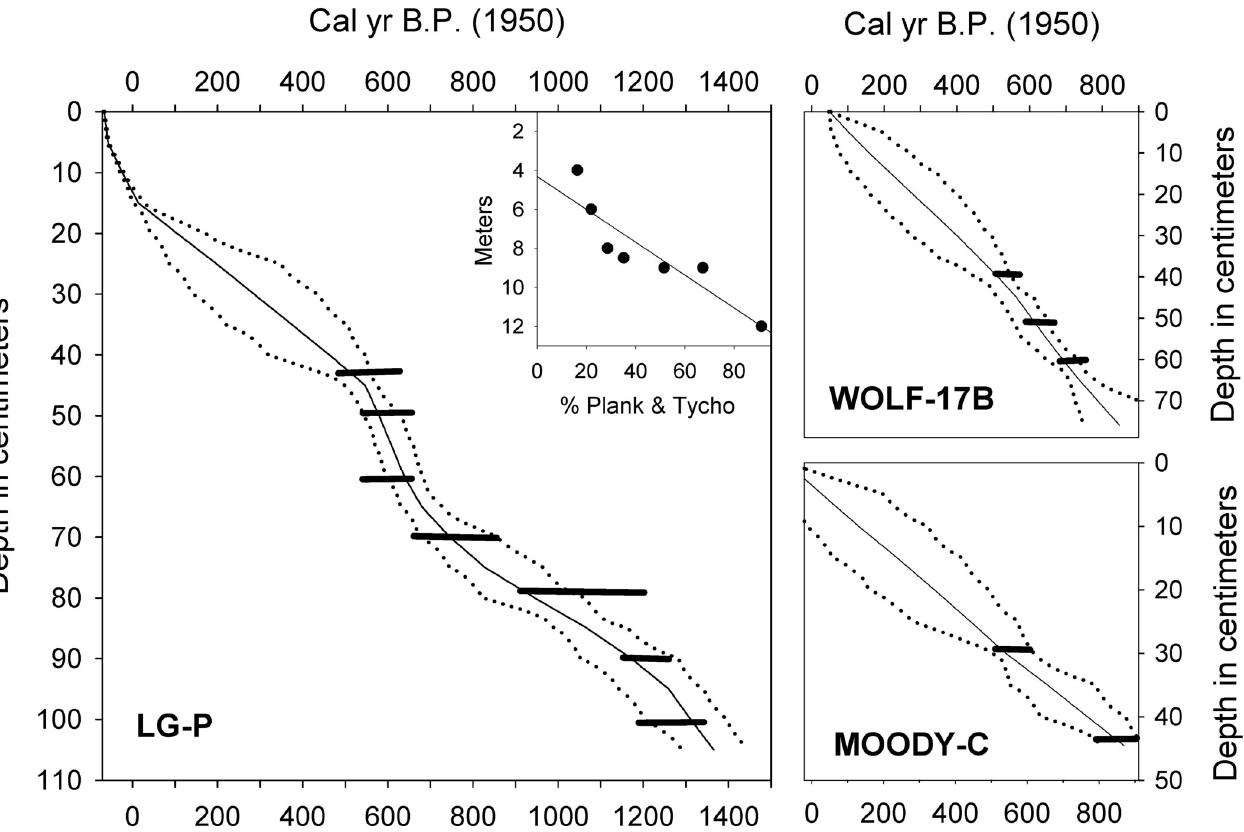
Fig 2. Radiocarbon age-depth models for sediment cores from Little Green Pond (LG-P), Wolf Lake (WOLF-17B), and Moody Pond (MOODY-C). Horizontal bars represent calibrated age probability ranges (2- σ ) for the radiometric dates. Dotted (solid) lines represent maximum-minimum (mean) ages. Inset: percentages of planktonic and tychoplanktonic diatoms in surface sediment assemblages along a water depth gradient in Little Green